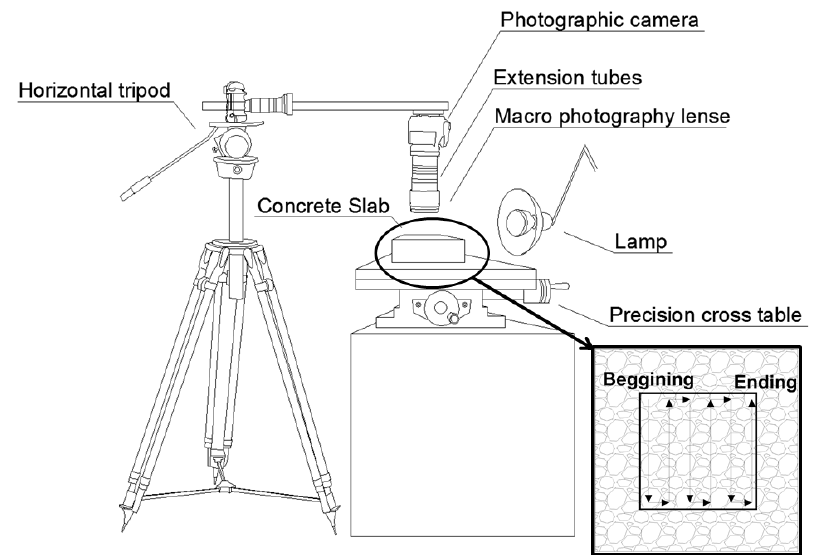
Figure 1. Experimental setup for the shooting of macro-photographic images of the surface analysed. In the corner of the picture, an example path for obtaining macro-photographic images covering the whole area of analysis.